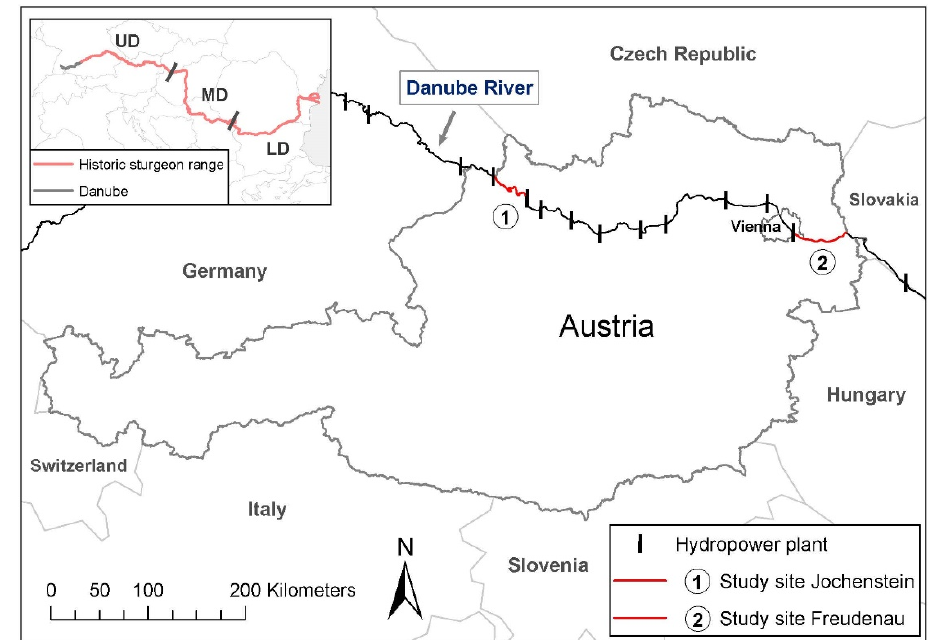
Figure 2. Location of the study sites.